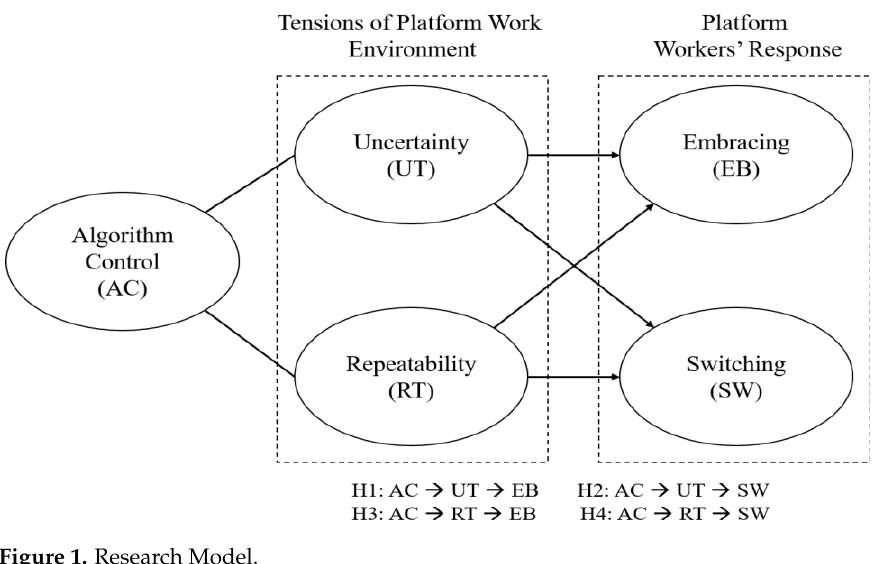
Figure 1. Research